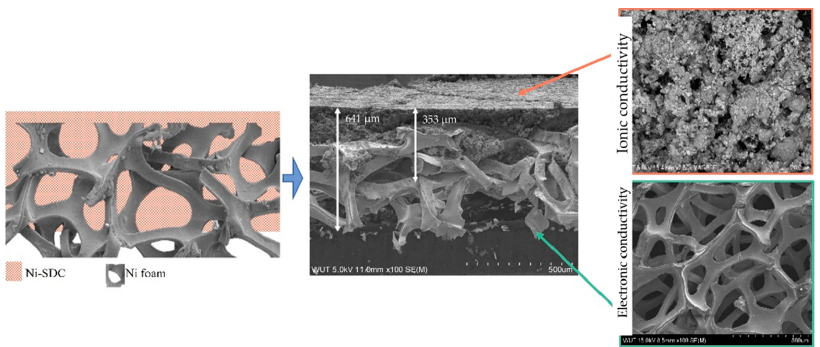
Figure 1. Construction of a two-layer Ni-SDC cathode.